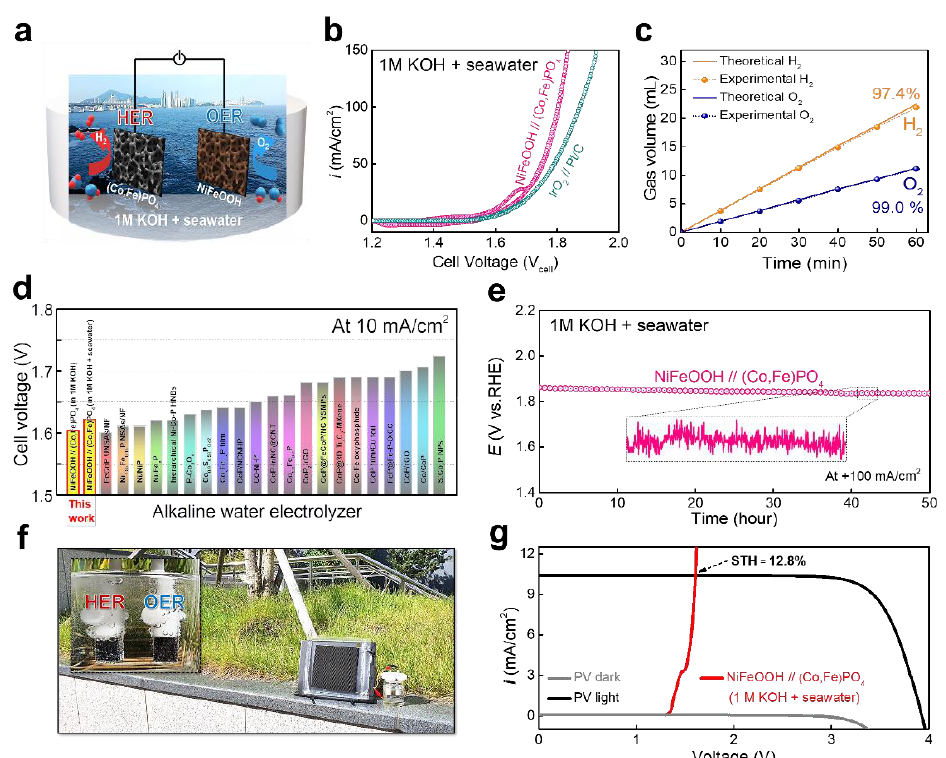
Figure 5. Overall seawater splitting. ( a ) Schematic of the alkaline seawater electrolyzer. ( b ) Polarization curves of the NiFeOOH//(Co,Fe)PO 4 electrolyzer compared with that of the IrO 2 //Pt/C noble-metal electrolyzer in the 1 M KOH + seawater electrolyte. ( c ) FE at +50 mA/cm 2 for the overall seawater splitting. ( d ) Comparison of the performances of the alkaline water electrolyzer. ( e ) Durability test at a constant current density of +100 mA/cm 2 for 50 h in 1 M KOH + seawater. ( f ) Photograph of the setup of the solar-driven overall seawater-splitting system. ( g ) Current density – voltage (J – V) curves under dark and simulated AM 1.5G 100 mW/cm 2 illumination for commercial silicon solar cell combined with the seawater electrolyzer.